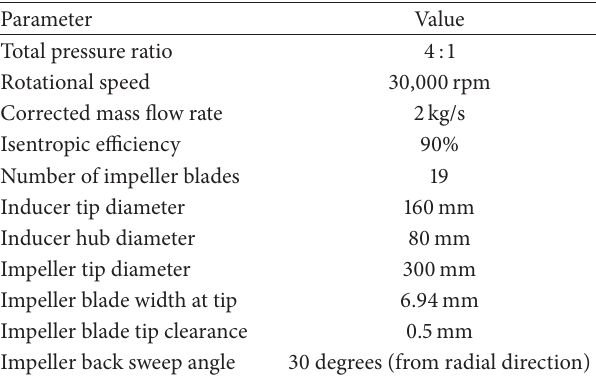
Table 1: Design specification of centrifugal